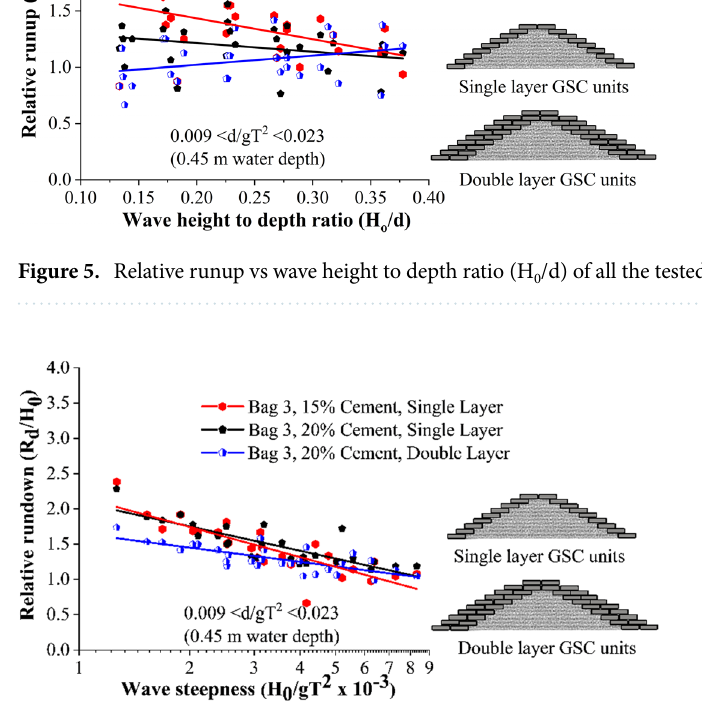
Figure 6. Relative rundown of all tested